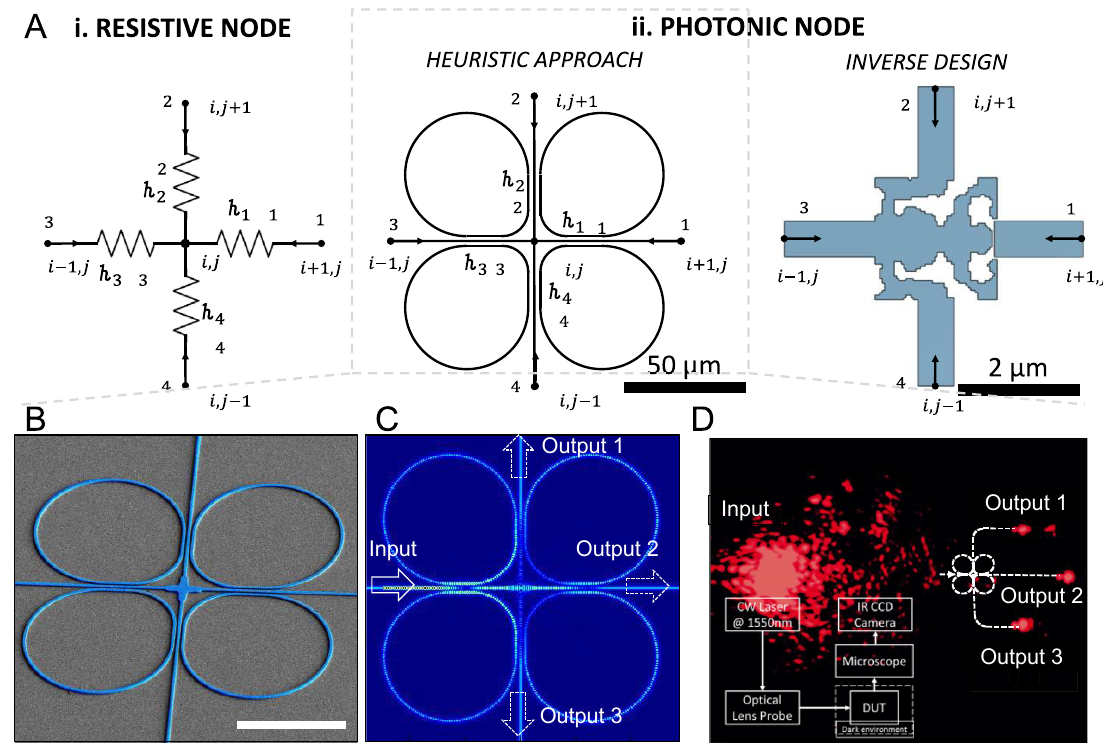
Figure 2: Kirchhoff ’ s photonic node (KPN). (A) nodemappingbetween( i ) aresistivemeshand( ii ) a photonicnode, designedeitherusing heuristic approachor inversedesign algorithm. Kirchhoff ’ s photonic node implemented either as waveguide crossing assisted by a four waterdrop-like ring resonators or using optimized inversedesign [17 – 19](representedwith regionsof silicon indicatedby blue,andsilicon dioxideindicated bywhite). (B)SEM micrograph(53 ° tilted) of a fabricated Kirchhoff ’ s photonic node (KPN). False color highlighted in light blue the silicon KPN. Scale bar 20 µm. (C) Electric fi eld distributionusing3DFDTDsimulationoftheKPN.ATMmodesourceisinjectedfromtheleftandaidedbythecraftedcouplingcoef fi cientssplit evenly in the other three cardinal directions. (D) The microscope image captured by infrared camera assessing the splitting with an inset showing our measurement setup. All simulation and measurement use light source at 1550 nm